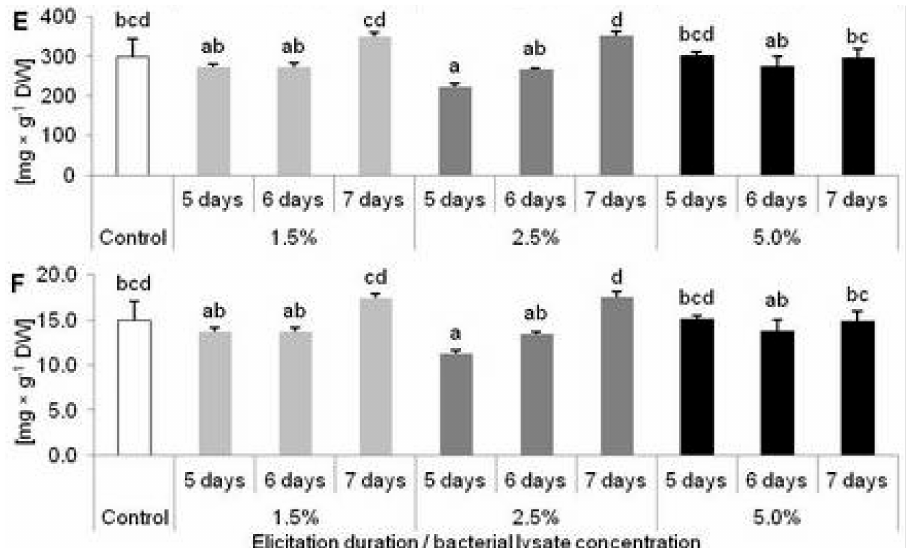
Figure 7. Accumulation of phenolic derivatives in Dionaea muscipula plants after five, six and seven days of elicitation with Cronobacter sakazakii lysate in di ff erent concentrations: ( A ) ca ff eic acid; ( B ) myricetin; ( C ) ellagic acid; ( D ) hyperoside; ( E ) salicylic acid; and ( F ) quercetin; di ff erent letters—significant di ff erence between means at p < 0.05, bar—standard deviation.